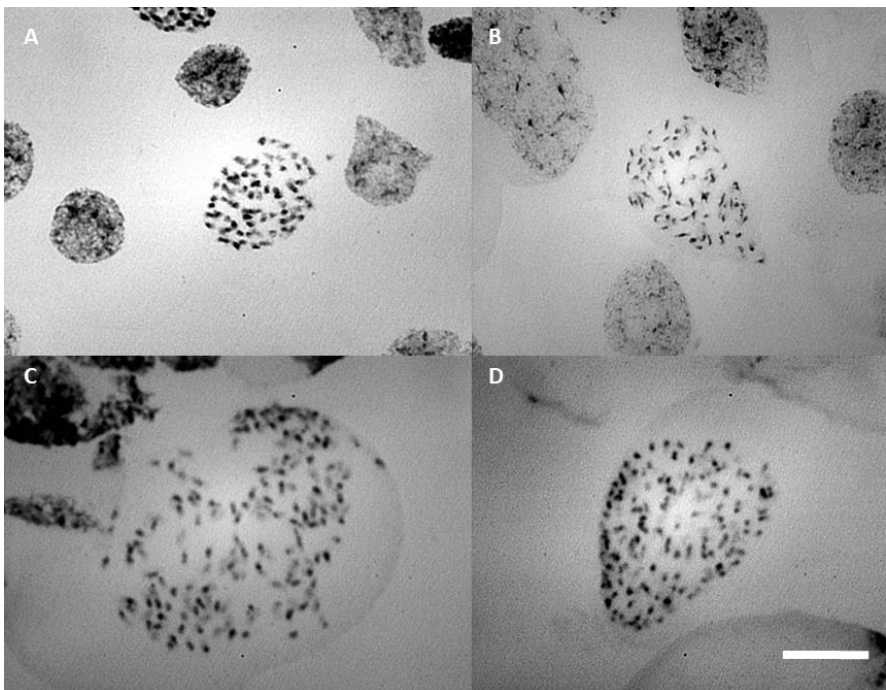
Figure 6. Prometaphase chromosome: ( A ) progeny of Blc. Haw Yuan Beauty × Blc. Goldenzelle “LC” without colchicine treatment; ( B ) Blc . Haw Yuan Beauty; ( C , D ) progeny of Blc. Haw Yuan Beauty × Blc . Goldenzelle “LC” treated with colchicine. Scale bar = 10 μm.